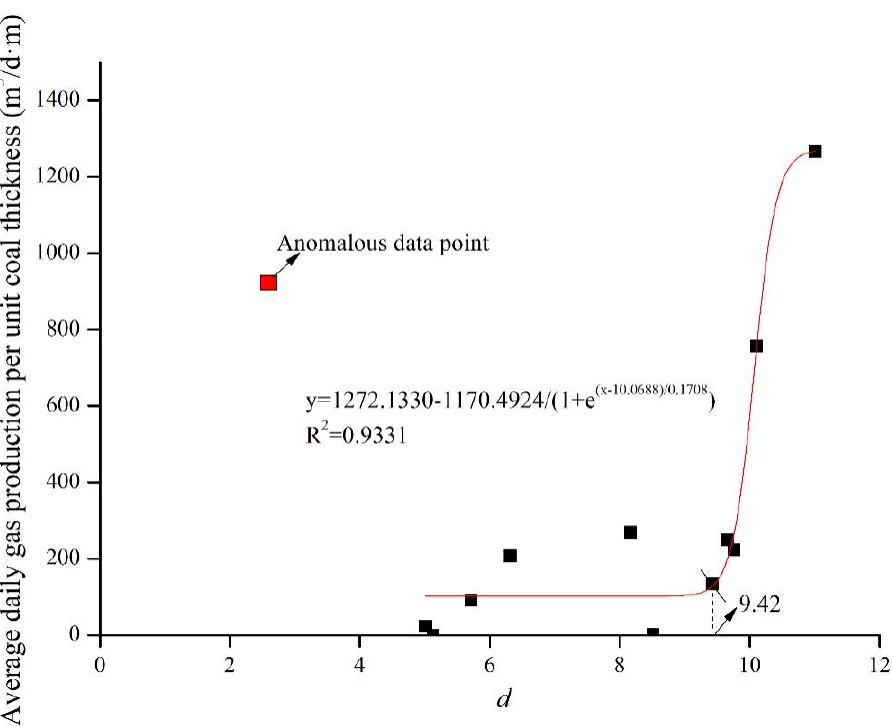
Figure 6. Relationship between d and the average daily gas production per unit coal thickness.